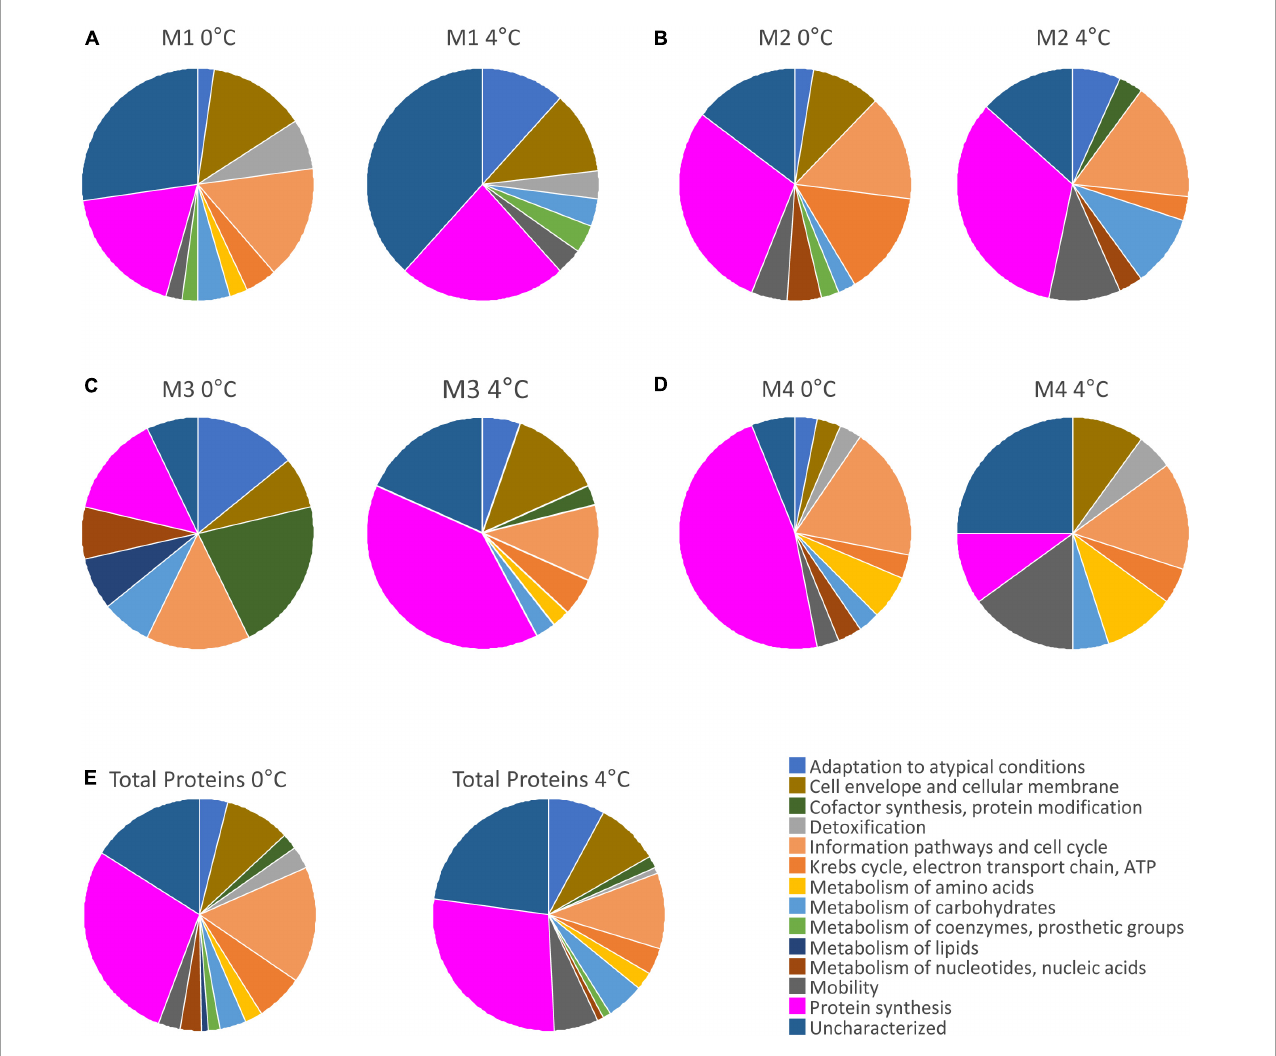
FIGURE5 Pie charts comparing protein distribution at 0 and 4 ◦ C. (A–D) Pie charts corresponding to samples M1–M4, respectively. (E) Total protein distribution at 0 and 4 ◦